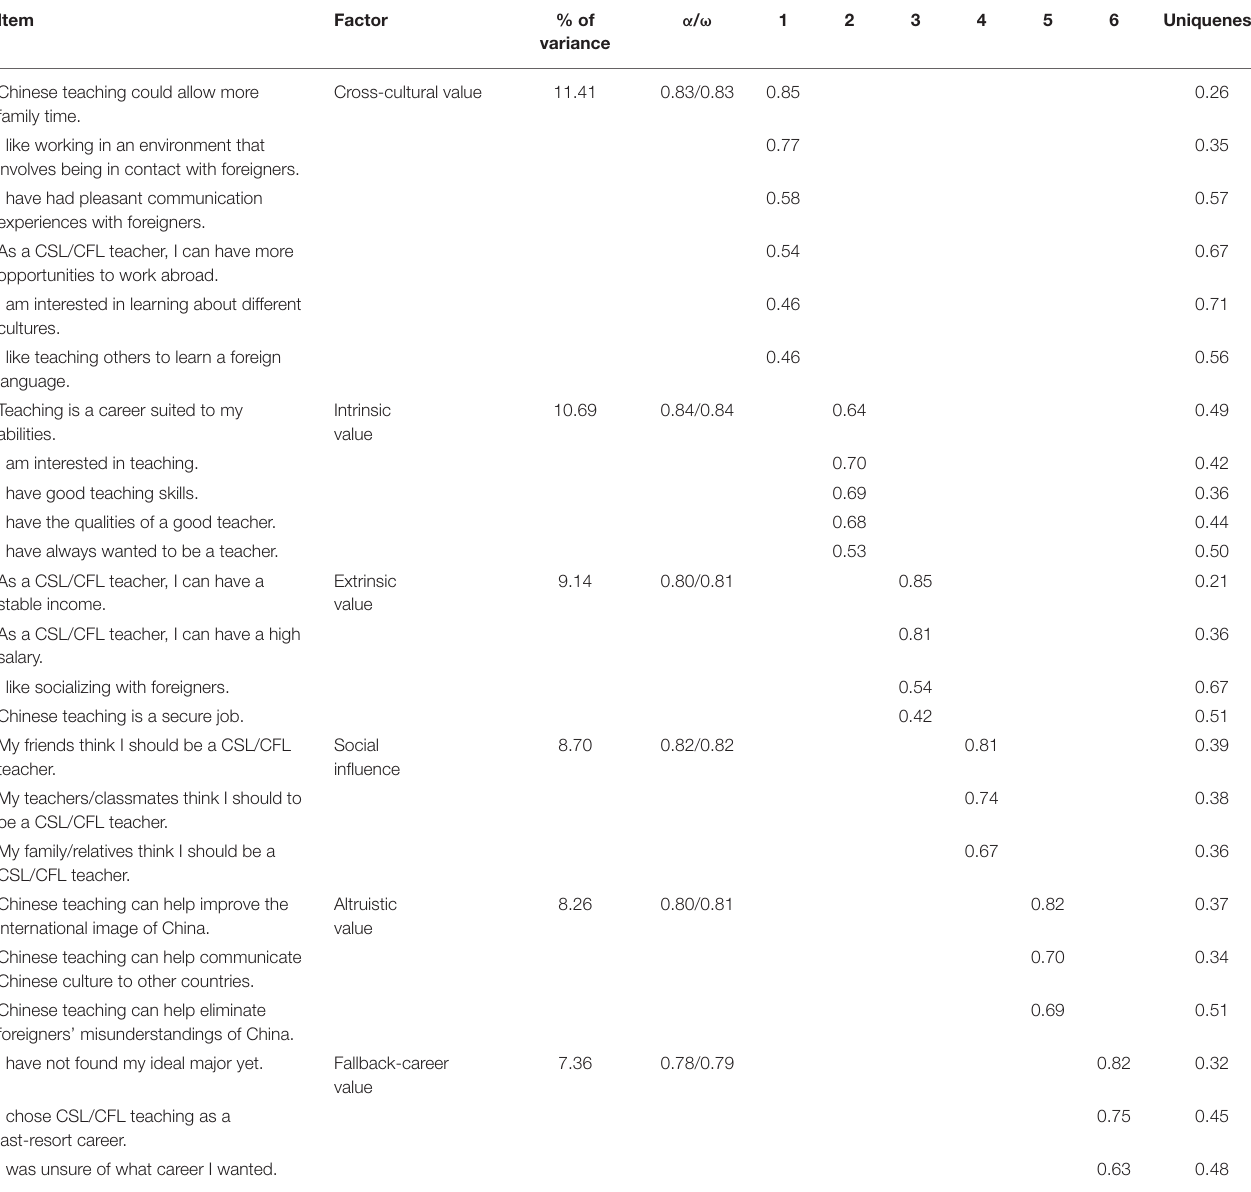
TABLE 4 | Summary of the factor loadings of EFA (native group). Item